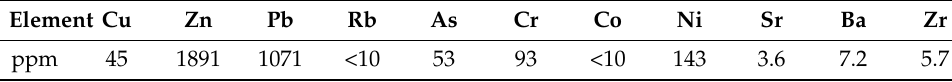
Table 3. Hazardous elements in CRT glass (XRF analysis).